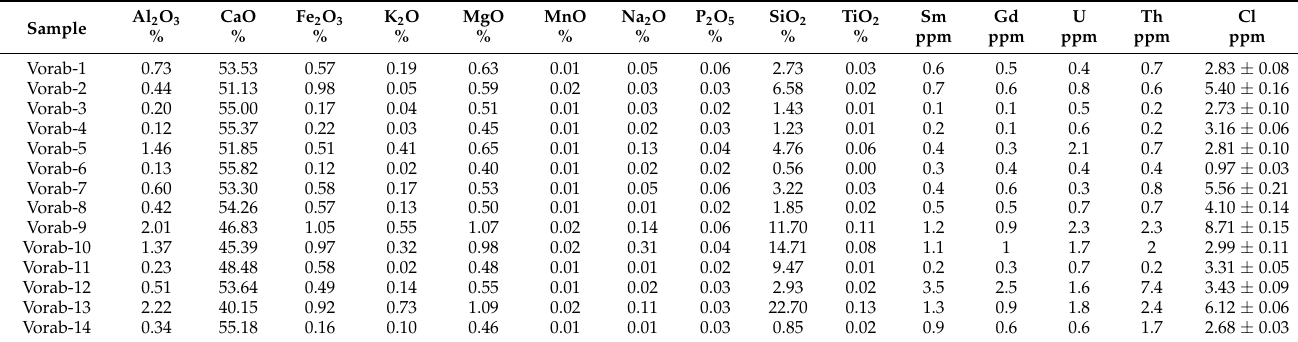
Table 2. Elemental composition of leached samples. Cl values are from AMS measurements. Sample